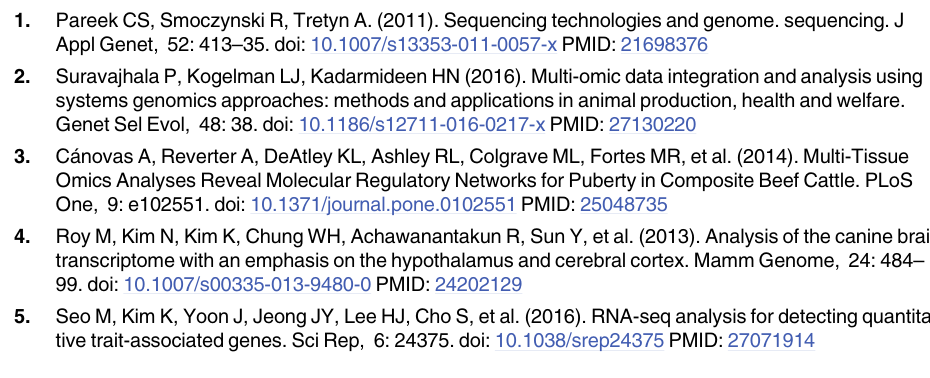
S63 Table. Hardy-Weinberg test for genetic differentiation of investigated cattle breeds using the Markov chain